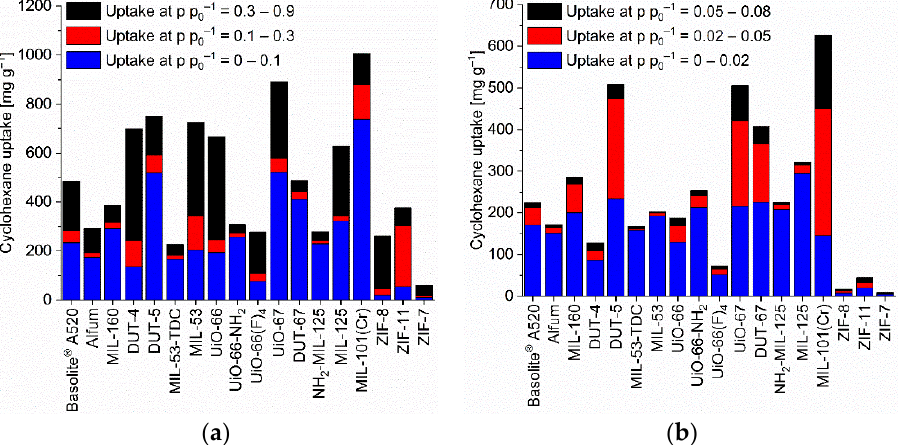
Figure 2. Benzene uptake capacity (at 293 K) of the different MOFs at different relative pressures. ( a ) At relative pressures of 0.1, 0.3 and 0.9; ( b ) at relative pressures of 0.02, 0.05 and 0.08 (specific values in Table S5). For the surface-specific uptake at p p 0 − 1 = 0.1 see Figure S88a.